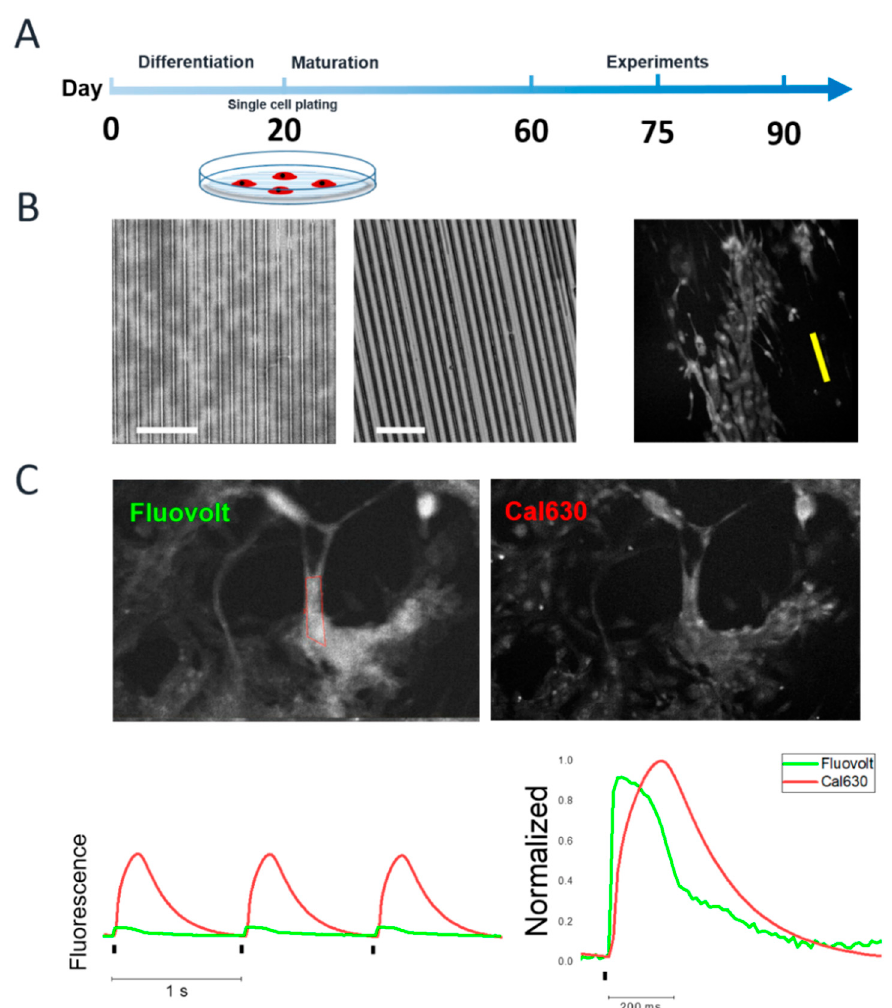
Figure 1. Experimental procedure. Human iPSCs are differentiated into cardiomyocytes (hiPSC-CMs) with monolayer-directed differentiation protocol. ( A ) At day 20 post differentiation, single hiPSC-CMs are seeded onto hydrogel-based micropatterned surface and cultured until experimental day 60, 75 and 90. ( B ) Left: fabrication of micropatterned hydrogel with PDMS mold and PEG-DA hydrogel synthesis by soft lithography (scale bars equal to 10 and 60 µm respectively). hiPSC-CM preferential spreading along thepattern direction (indicated by yellow line). ( C ) Simultaneous recording of action potential and calcium transients using Fluovolt (Ex/em 522/535 nm) and Cal630 (Ex/Em 608/626 nm), respectively.